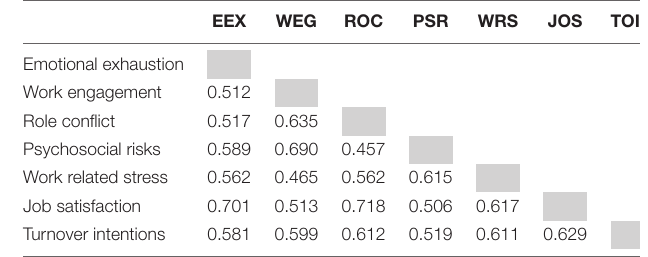
TABLE 1 | Fornell-Larcker criterion. WEG ROC PSR WRS JOS